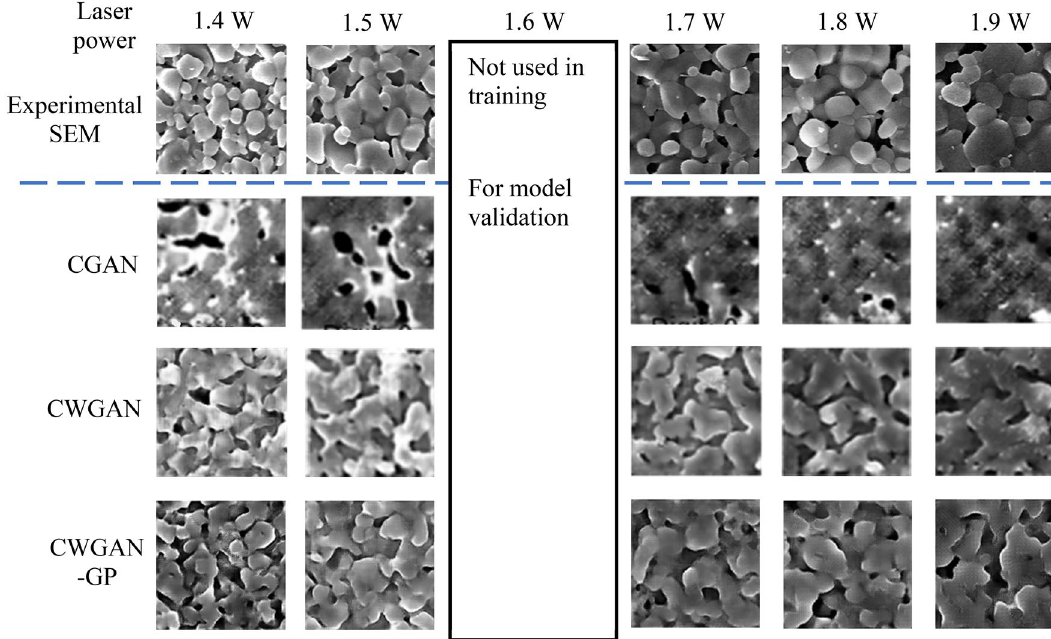
Figure 2. The examples from the real SEM image dataset, and the regenerated micrographs using CGAN, CWGAN, and CWGAN-GP.